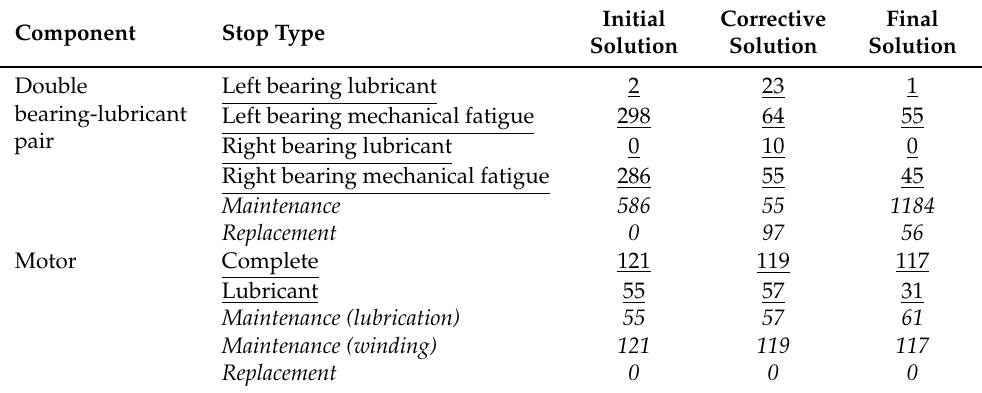
Table 26. Numbers of stop instances yielded from training the model with standalone uncoated roller for the bleaching machine (ZORLUTEKS) within the simulation interval (200 years). Underlined and italic contents correspond to failures and strategies, respectively.